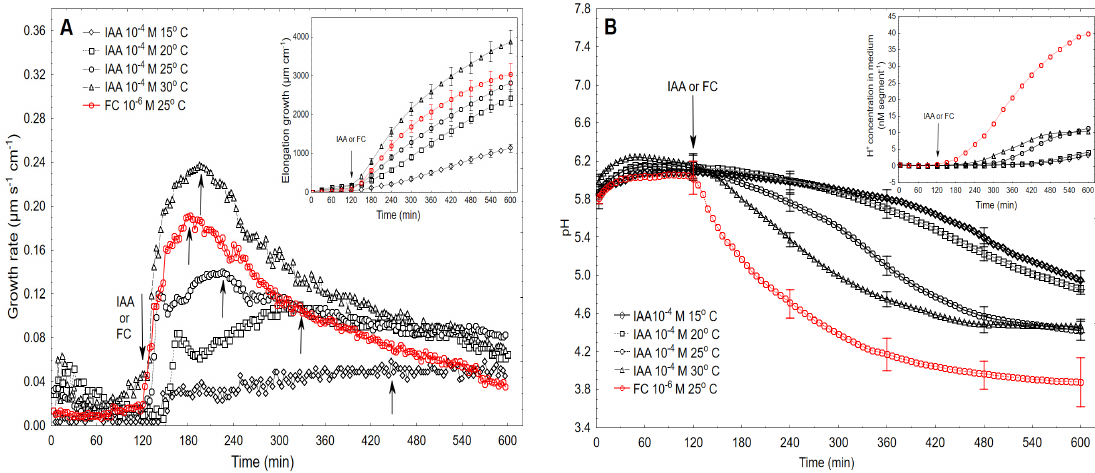
Figure 4. Effect of temperature (15, 20, 25 and 30 °C) on the growth rate ( A ) and medium pH ( B ) of the maize coleoptile segments that had been incubated in the presence of the optimal concentration of the IAA (10 − 4 M). For comparison, the effect of the optimal concentration of FC (10 − 6 M, red curve) at 25 °C is also shown. After preincubation (over 120 min at the desired temperature) of the coleoptile segments in the control medium, IAA was added (arrow). The arrow pointing up indicates movement to the left the second phase of the IAA-induced growth and the maximal growth rate that was induced by FC. The inset in Figure 4A shows the total elongation growth (µm cm − 1 ), which was calculated as the sum of the extensions from 3 min interval measurements over 10 h; however, the one in Figure 4B shows the medium pH changes expressed as changes in the H + concentration per coleoptile segment. The medium pH changes were measured simultaneously with growth (Figure 4A) using the same tissue samples. All of the curves are the means of at least seven independent experiments. Bars indicate ± SE.